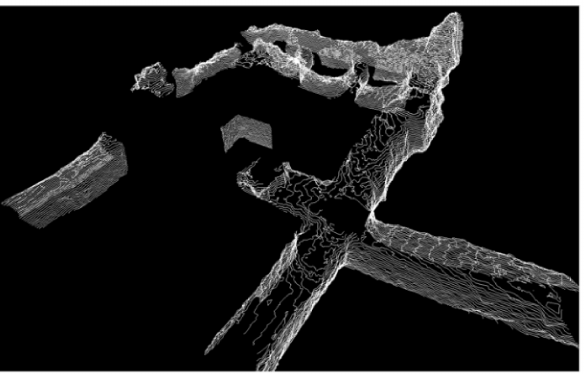
Figure 15. Contours with equidistance 10 cm relative to the underground portions where the rock- mass is outcropping.